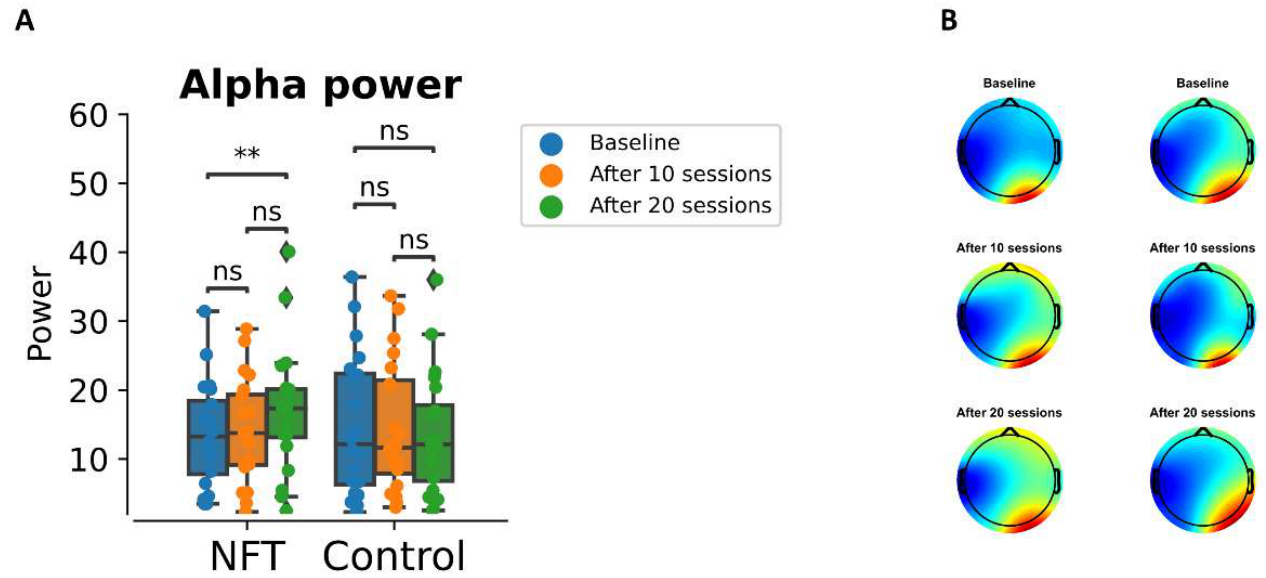
Figure 4. ( A ) The plot shows the absolute alpha power at baseline, after 10 sessions and after 20 sessions for both groups. ( B ) the topographical plots of absolute alpha power in NFT group (left column) and Control group (right column). ** p < 0.001; ns, not significant. (left column) and Control group (right column). ** p < 0.001; ns, not